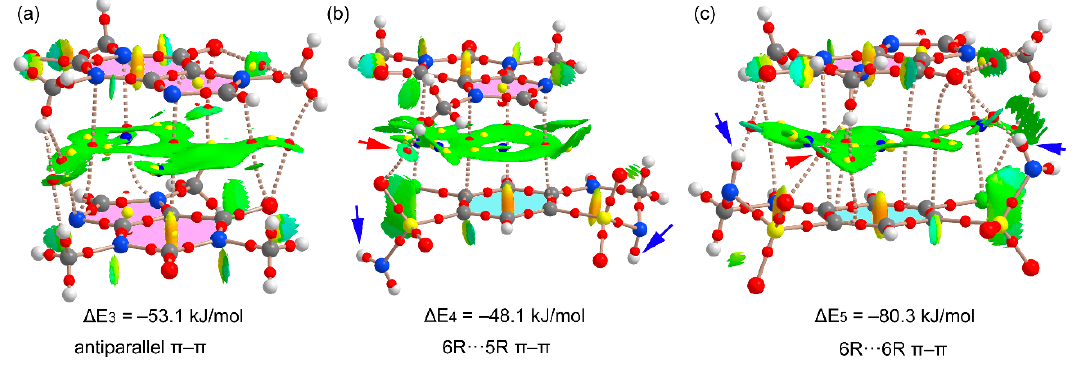
Figure 11. Combined QTAIM / NCIplot analysis of the π -stacked CAF ··· CAF homodimer ( a ) and CAF ··· HCT heterodimers ( b , c ) extracted from the solid-state X-ray structure of HCT–CAF.